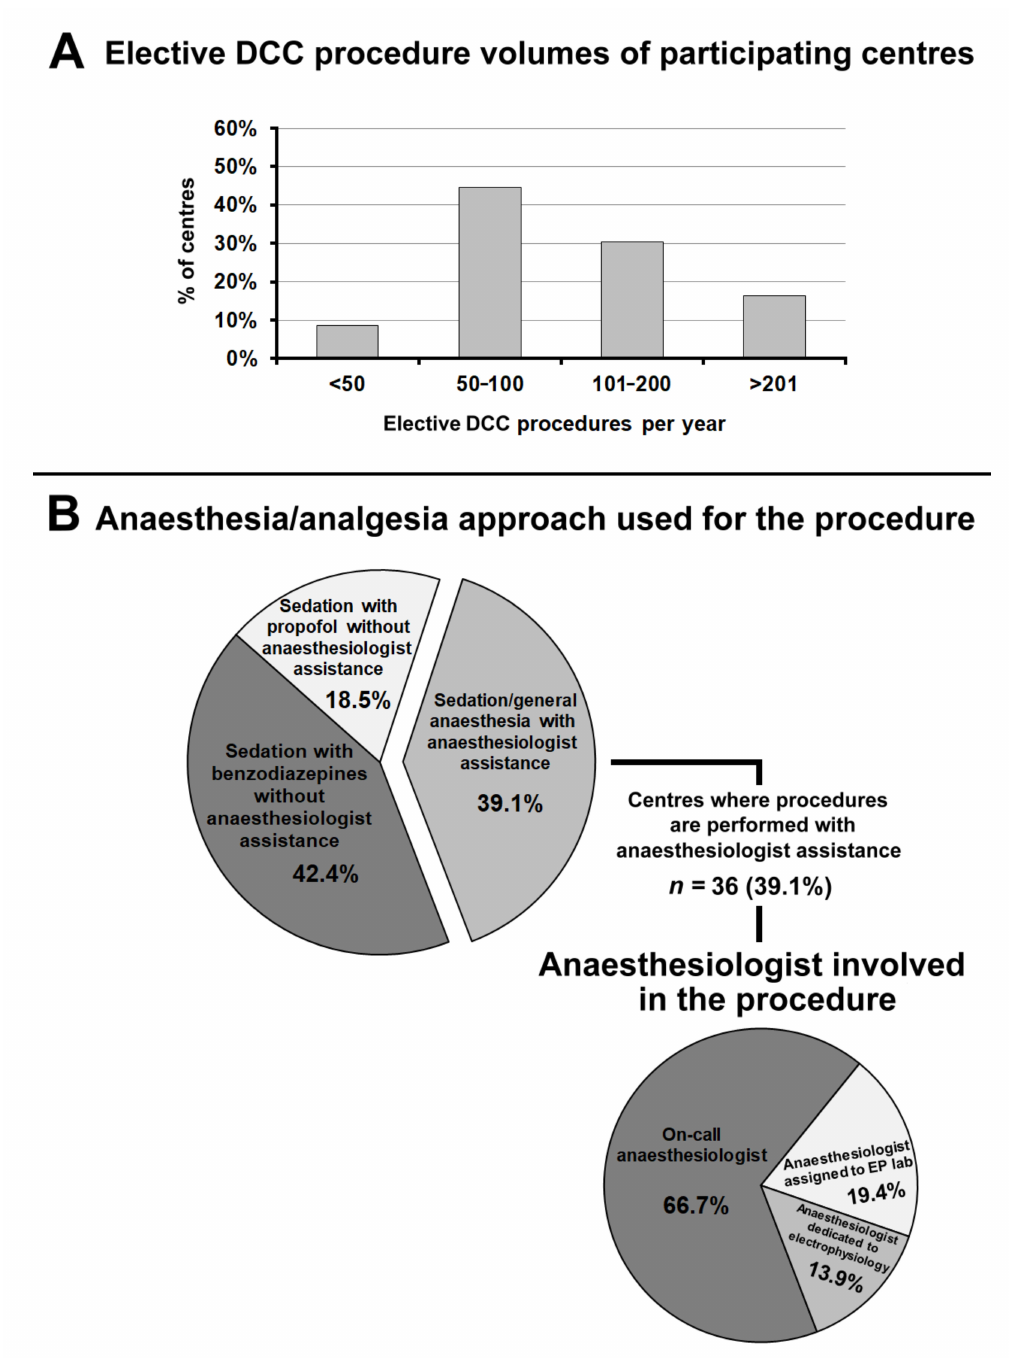
Figure 2. ( Panel A ): Elective direct-current cardioversion procedure volumes of participating centres. ( Panel B ): Anaesthe- sia/analgesia approach used for the procedure. Abbreviations used in the figure. DCC: direct-current cardioversion; EP lab: electrophysiology